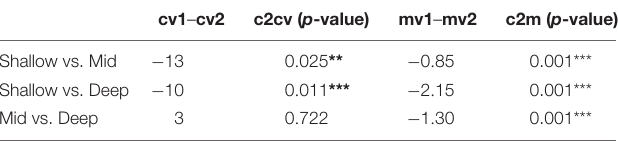
TABLE 4 | Results of comparison of cumulative species richness (c2cv) and mean species richness (c2m) by depth levels with randomization